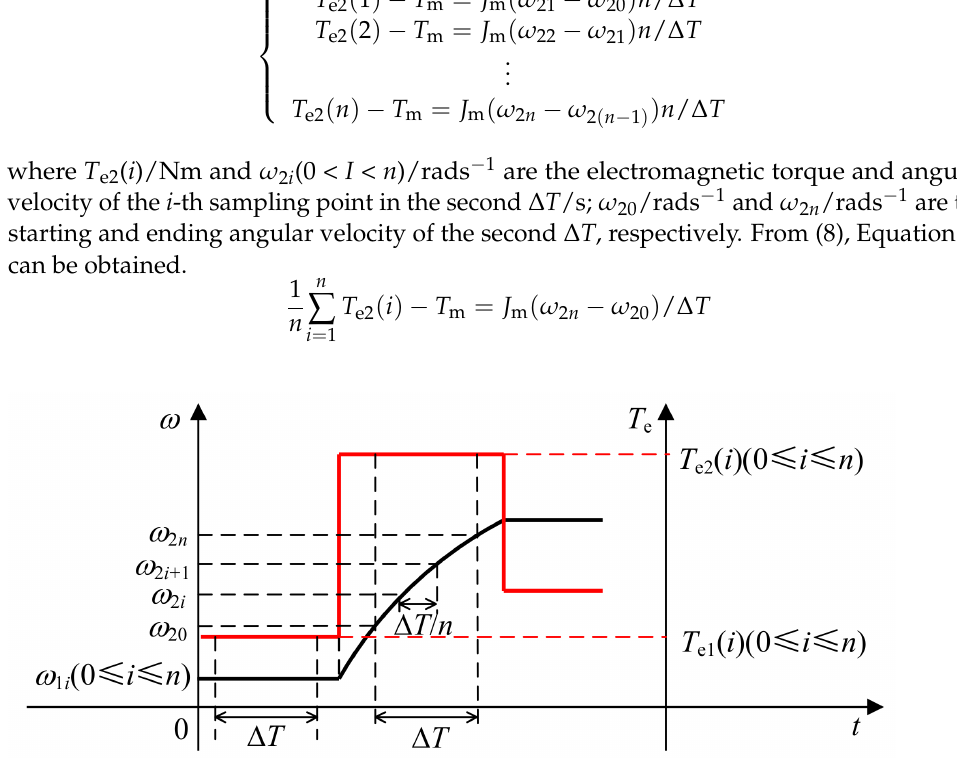
Figure 1. Schematic diagram of the improved acceleration deceleration